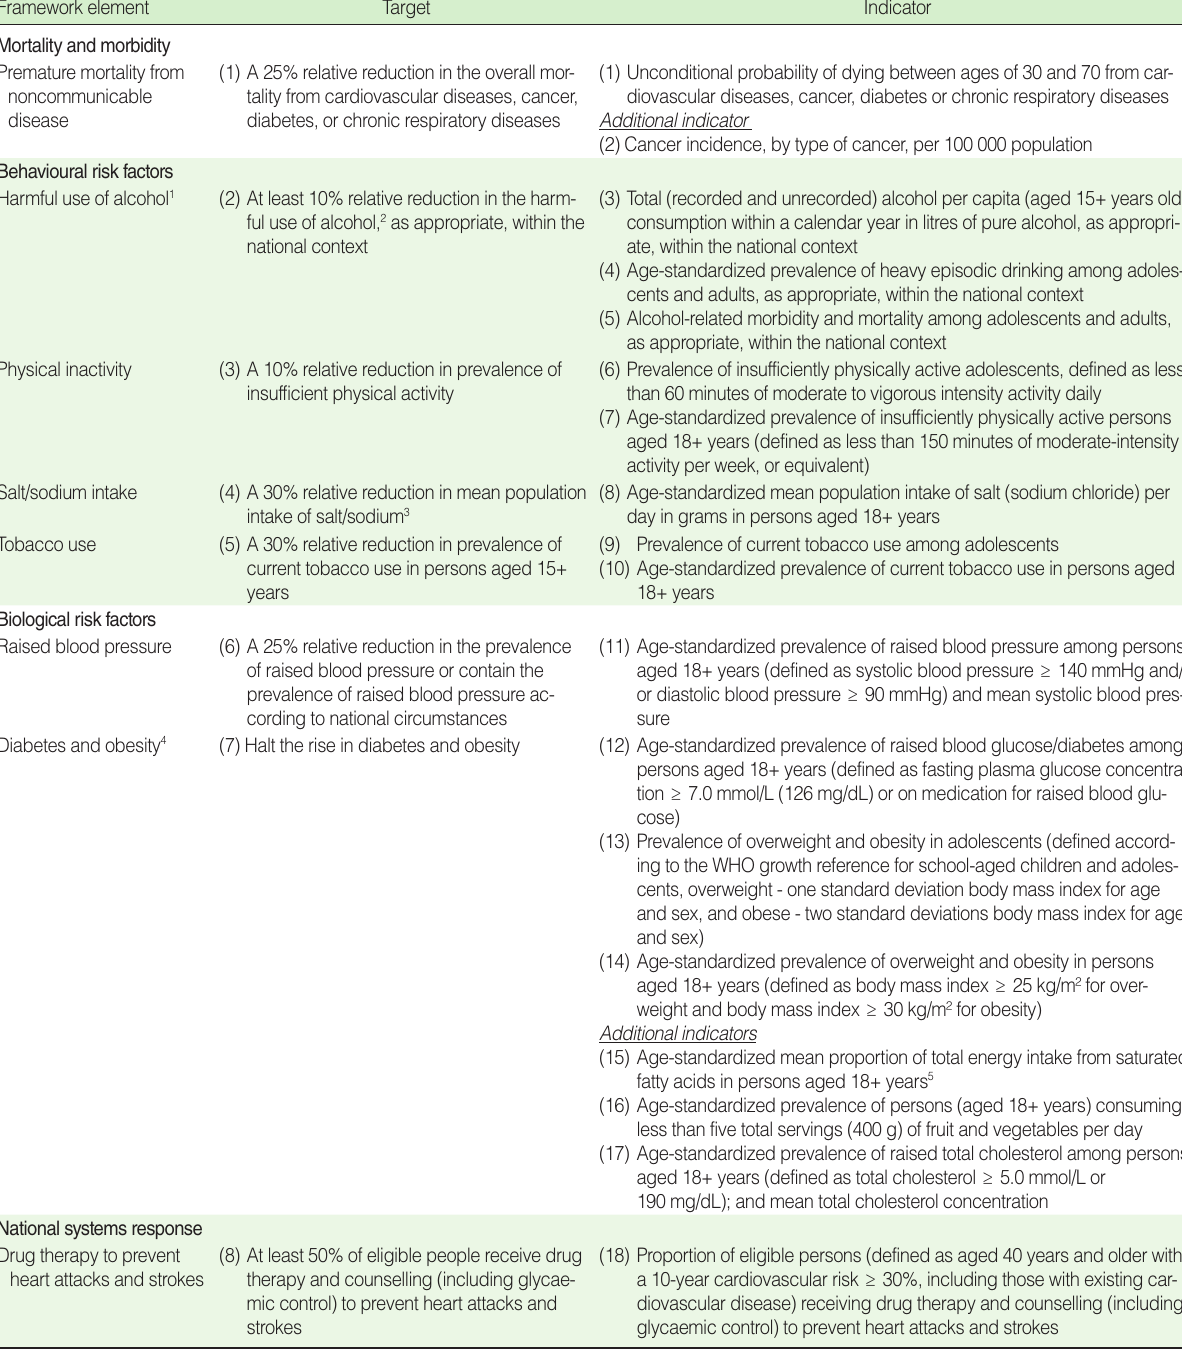
Table 2. Comprehensive global monitoring framework, including 25 indicators, and a set of nine voluntary global targets for the